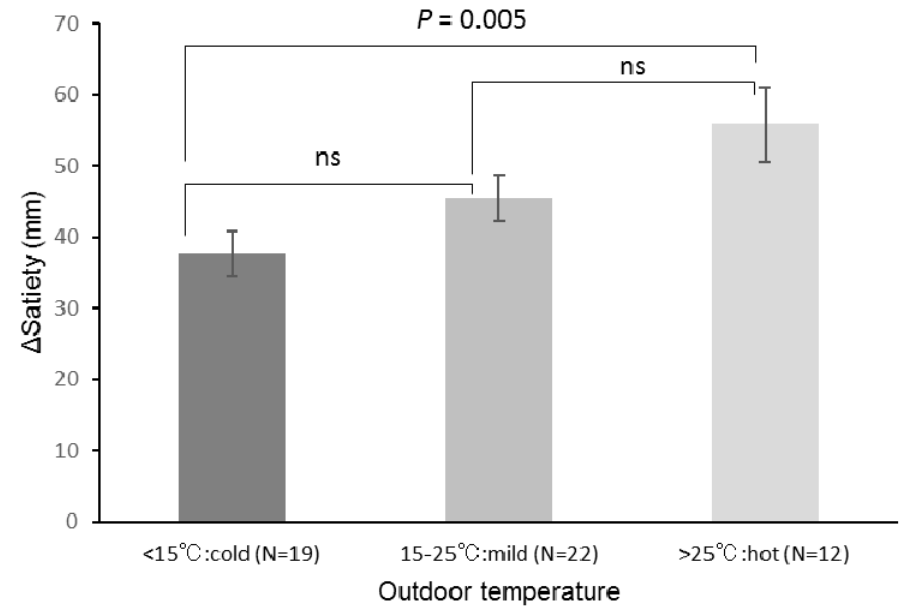
Figure 1. Comparison of ∆ satiety at stratified outdoor temperatures. ∆ satiety of participants was stratified into three groups by outdoor temperature (<15 ◦ C, cold; 15 ◦ C–25 ◦ C, mild; >25 ◦ C, hot). Values are means ± standard errors. p values based on one-way ANOVA in stratified outdoor temperature groups.